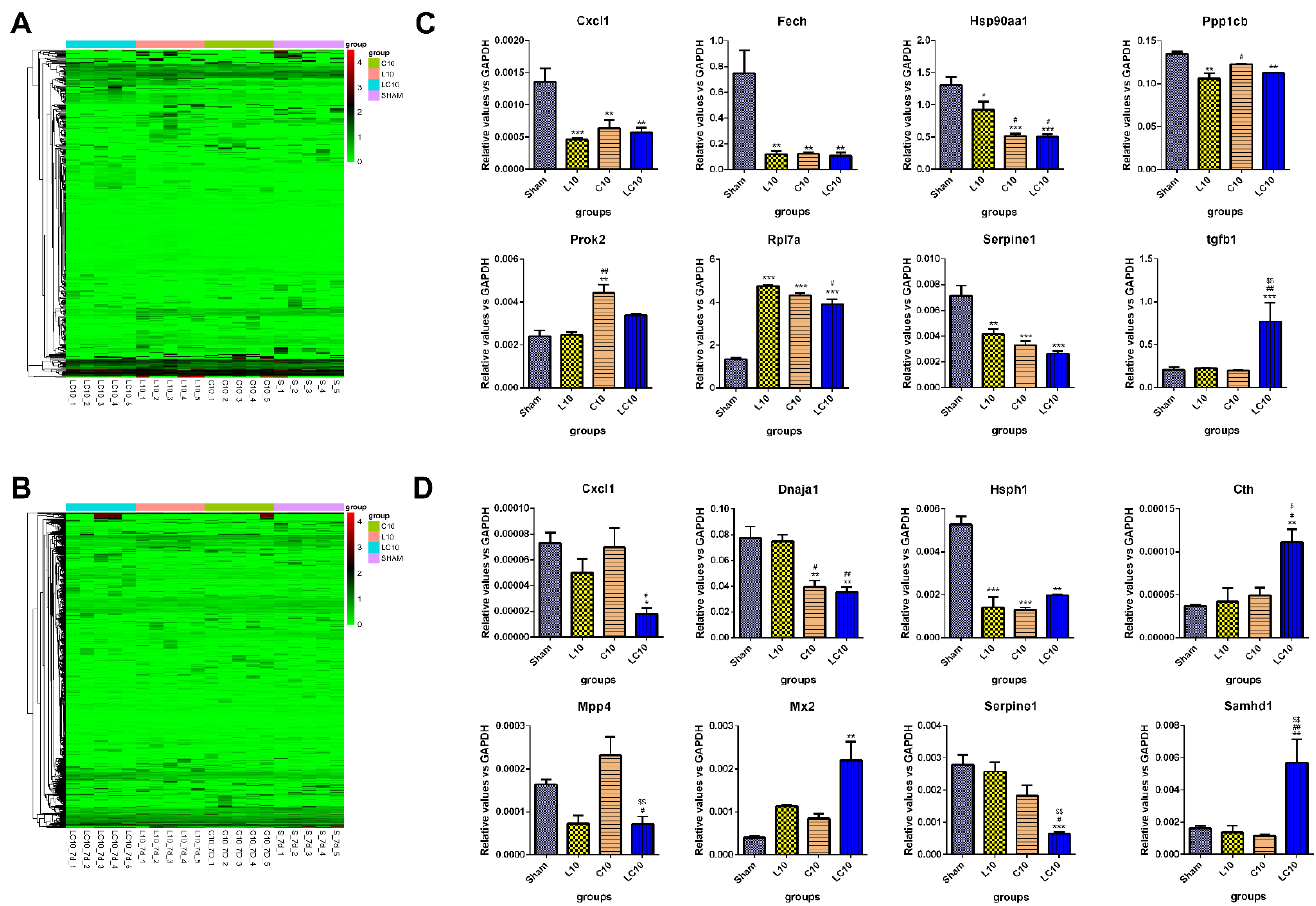
Figure 4. Transcriptomic analysis of differentially expressed genes (DEGs) in both peripheral blood and the spleen at 7 d after microwave exposure. At 7 d after microwave exposure, the peripheral blood and the spleen were collected from Sham group, L10 group, C10 group and LC10 group, as described in Section 4. The cDNA library was constructed, and the quality of cDNA library was confirmed by using the Agilent high sensitivity DNA assay on a Bioanalyzer 2100 system. Then, high throughput sequencing was conducted to investigate DEGs. The DEGs in peripheral blood ( A ) and the spleen ( C ) were analyzed by DESeq2 and were presented, respectively. Moreover, eight representative DEGs from peripheral blood (including Cxcl1, Fech, Hsp90aa1, Ppp1cb, Prok2, Rpl7a, Serpine1 and tgfb1) ( B ) and the spleen (including Cxcl1, Dnaja1, Hsph1, Cth, Mpp4, Mx2, Serpine1 and Samhd1) ( D ) were selected and then verified by real-time reverse transcription polymerase chain reaction (RT-PCR). Data were shown as mean ± s.e.m. *, p < 0.05, **, p < 0.01, ***, p < 0.001 vs. Sham group; #, p < 0.05, ##, p < 0.01 vs. L10 group; $, p < 0.05, $$, p < 0.01 vs. C10 group.